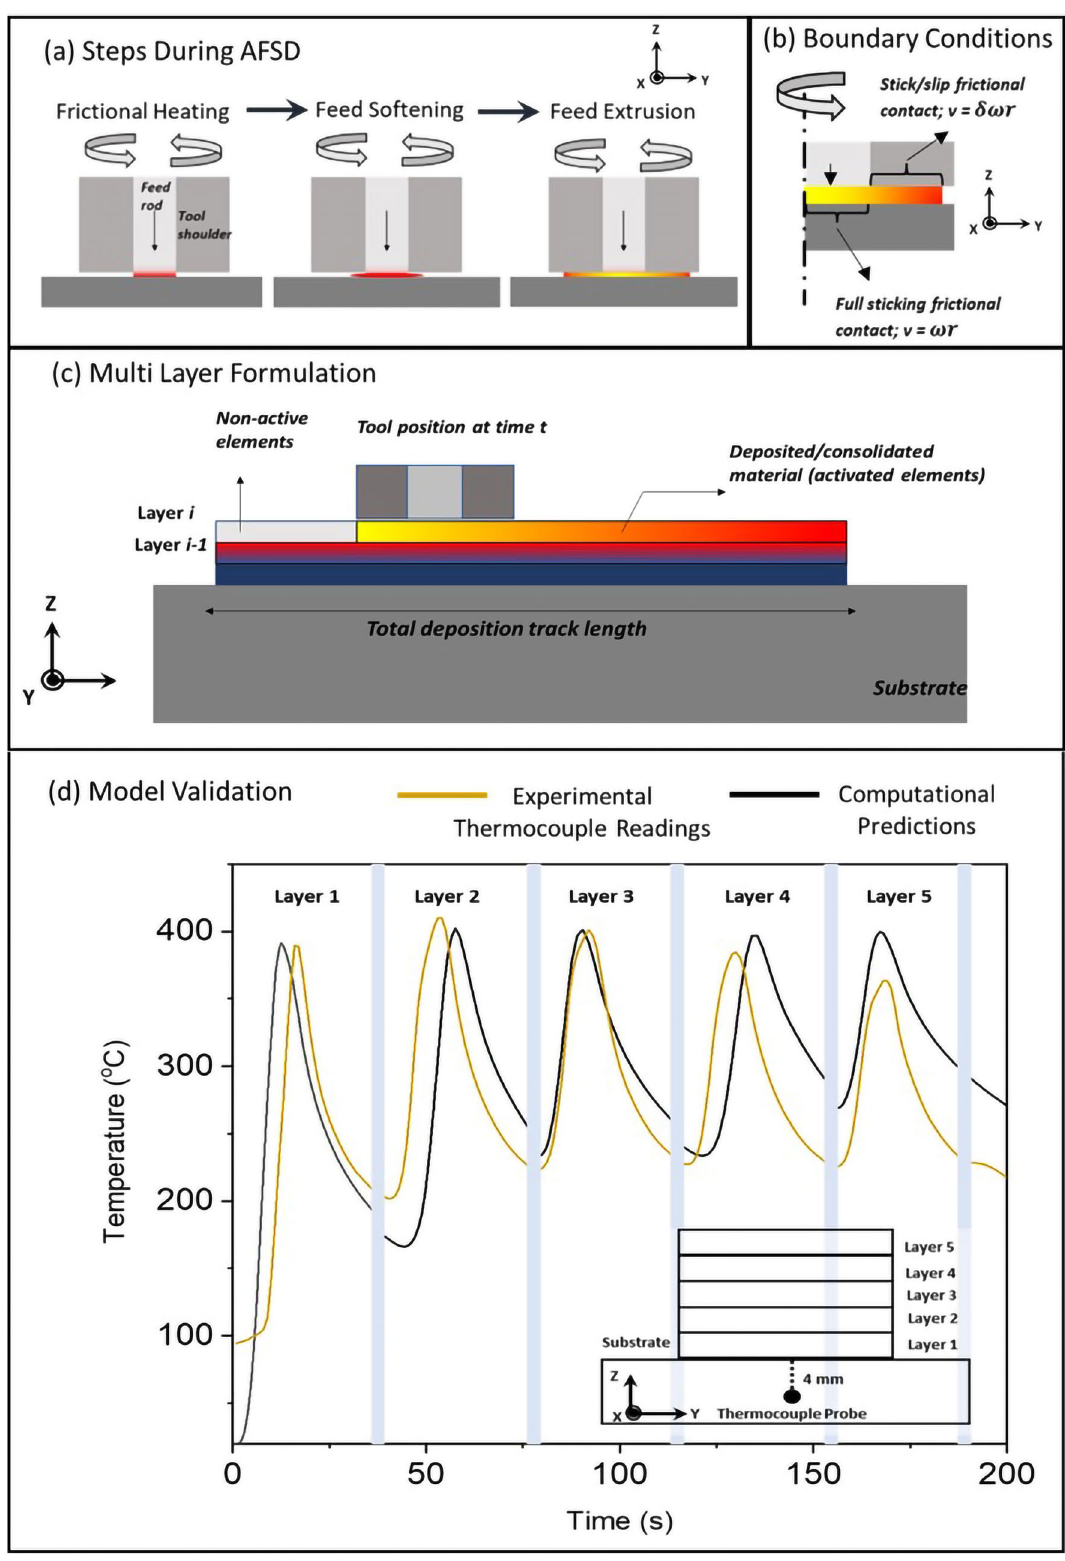
Figure 2. Schematics of multi-layer computational model methodology adopted in the current work showing ( a ) steps in AFSD process, ( b ) model boundary conditions, ( c ) multi layer formulation approach, and ( d ) validation exercise with the aid of time temperature plots showing thermocouple readings and multi layer computational process model